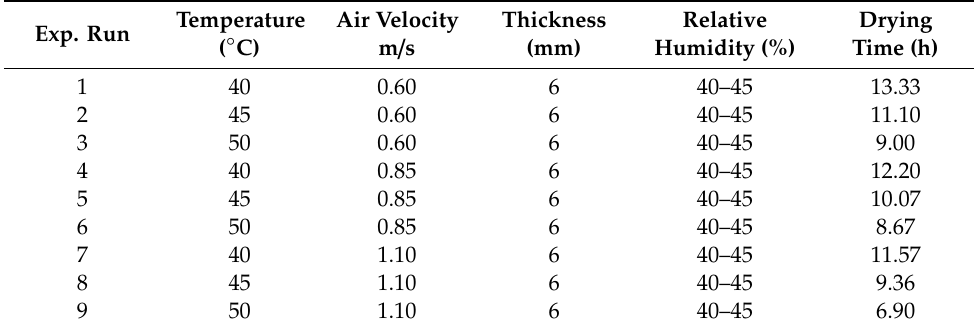
Table 7. E ff ect of air temperature and air flow velocity on the drying time.